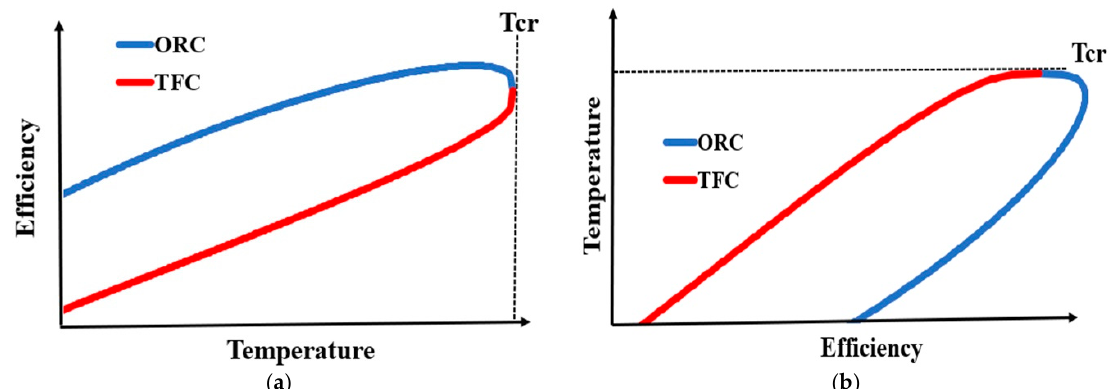
Figure 8. Schematic temperature-efficiency ( a ) and its inverse, efficiency-temperature ( b ) curves of an ORC-like and TFC- like system, explaining the necessity of the maximum. Further explanation can be found in the text.